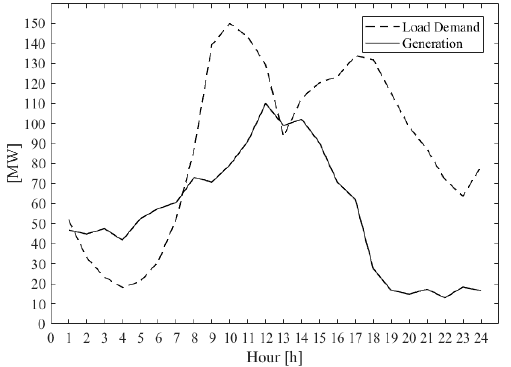
Figure 5. Daily profiles of total load and generation in Area 1.